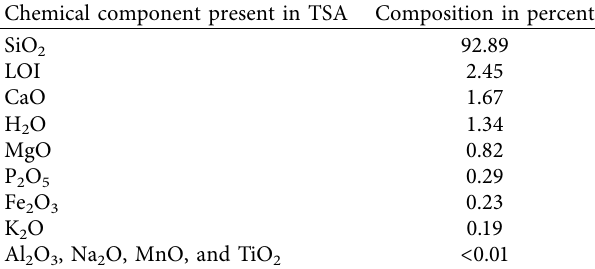
Table 1: Chemical composition of TSA. Chemical component present in